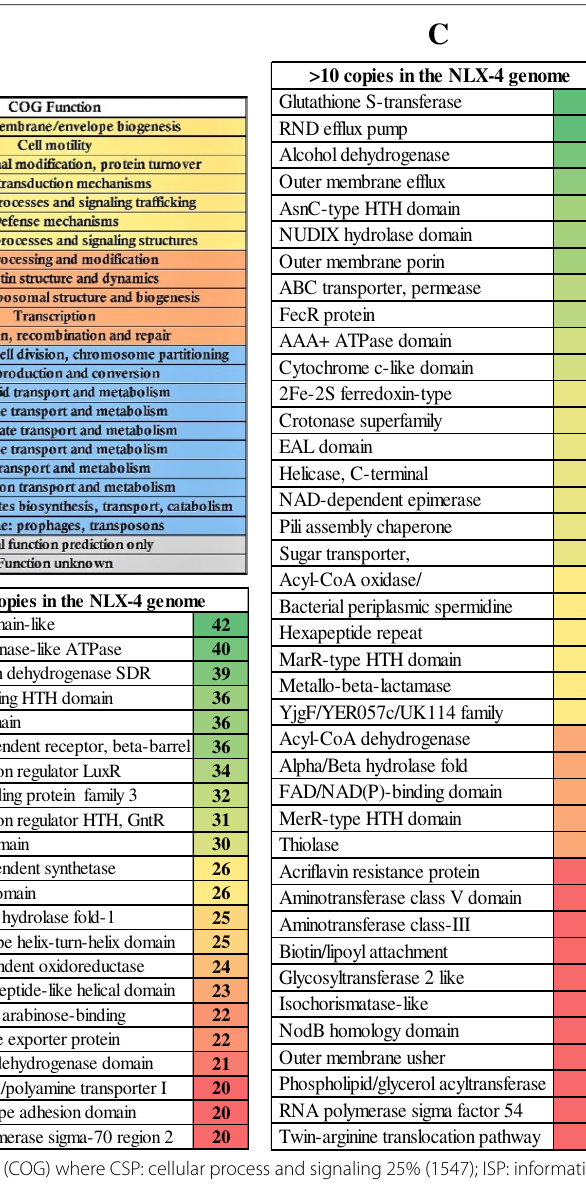
KEGG database has divided protein coding genes into 52%-metabolism, 6%-organismal systems, 5%-cellular processes, 14%-environmental information process- ing, 10%-genetic information and processing and 13%- human diseases, respectively (Fig. 3). Genes encoding for transcription regulator HTH (LysR), ABC trans- porter like, Signal transduction response regulator ABC transporter (Metl-like), GCN5-N-acetyltransferase